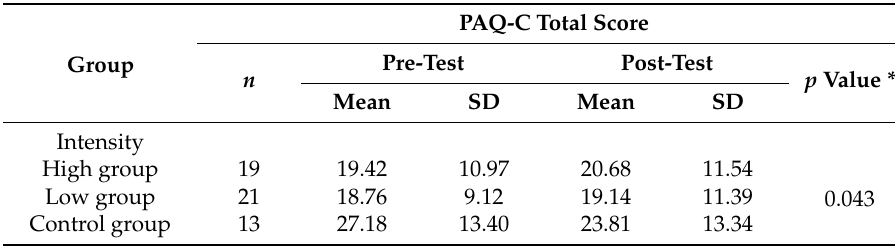
Table 4. SMS Frequency and PAQ-C